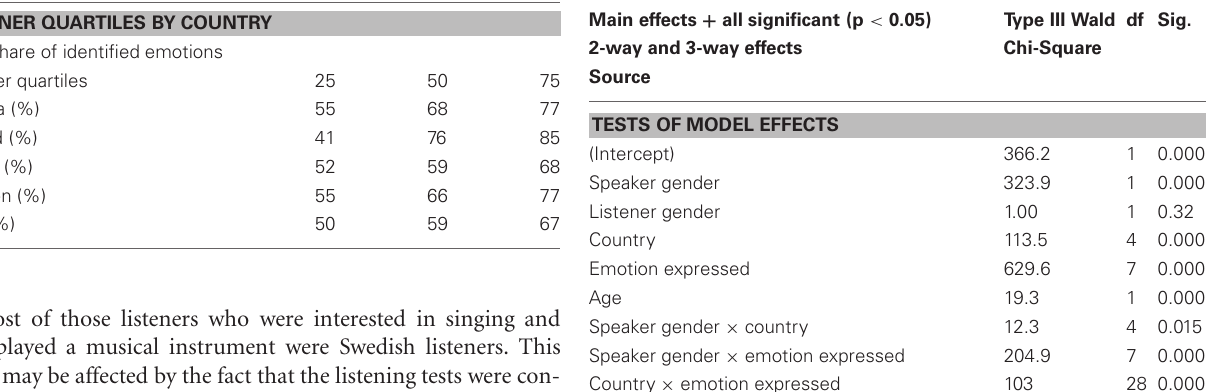
Table 6 | The quartiles for the shares of identified emotions studied by country.